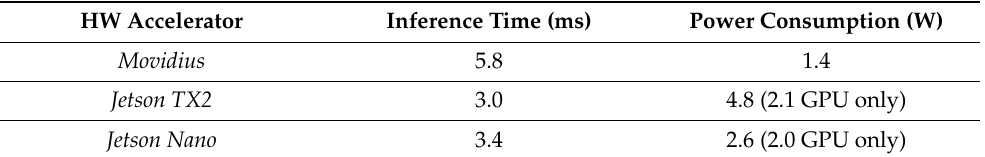
Table 9. Inference time and power consumption on the three hardware